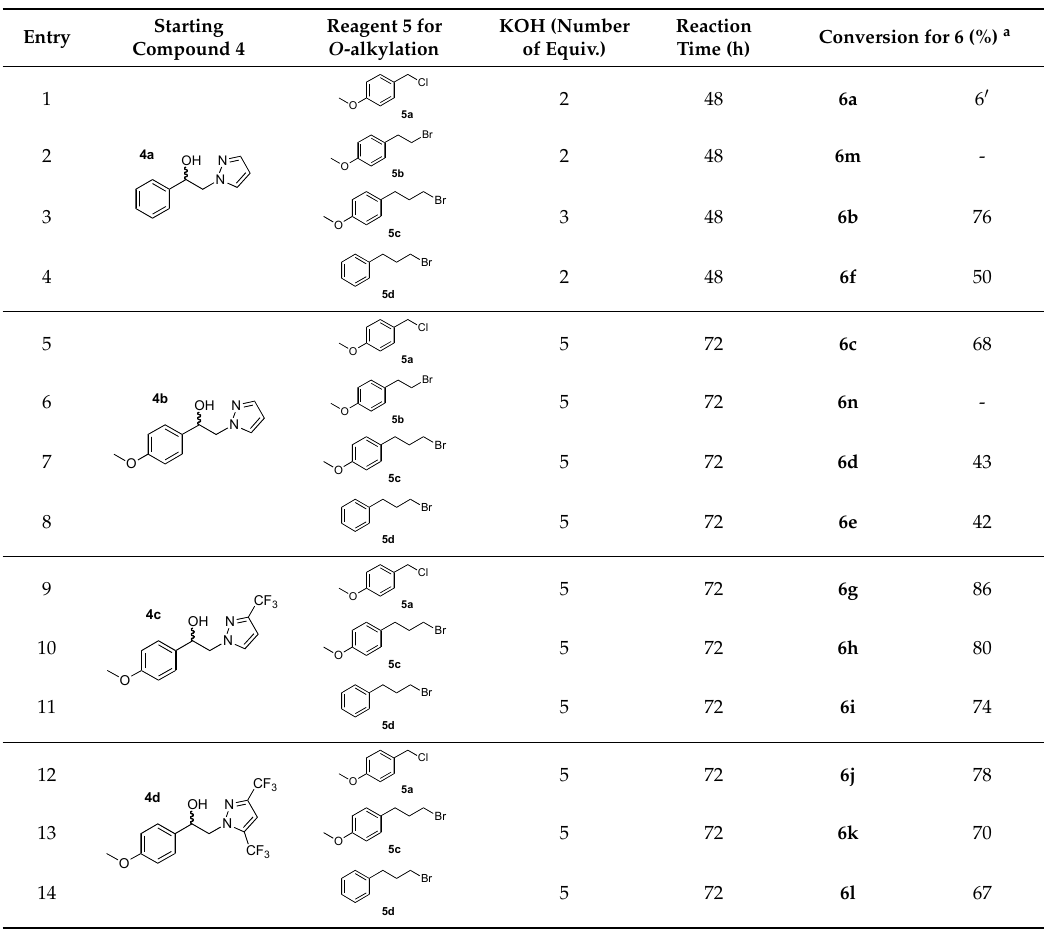
Table 2. Optimization of the reaction conditions for the preparation of the intermediates 6a – n .